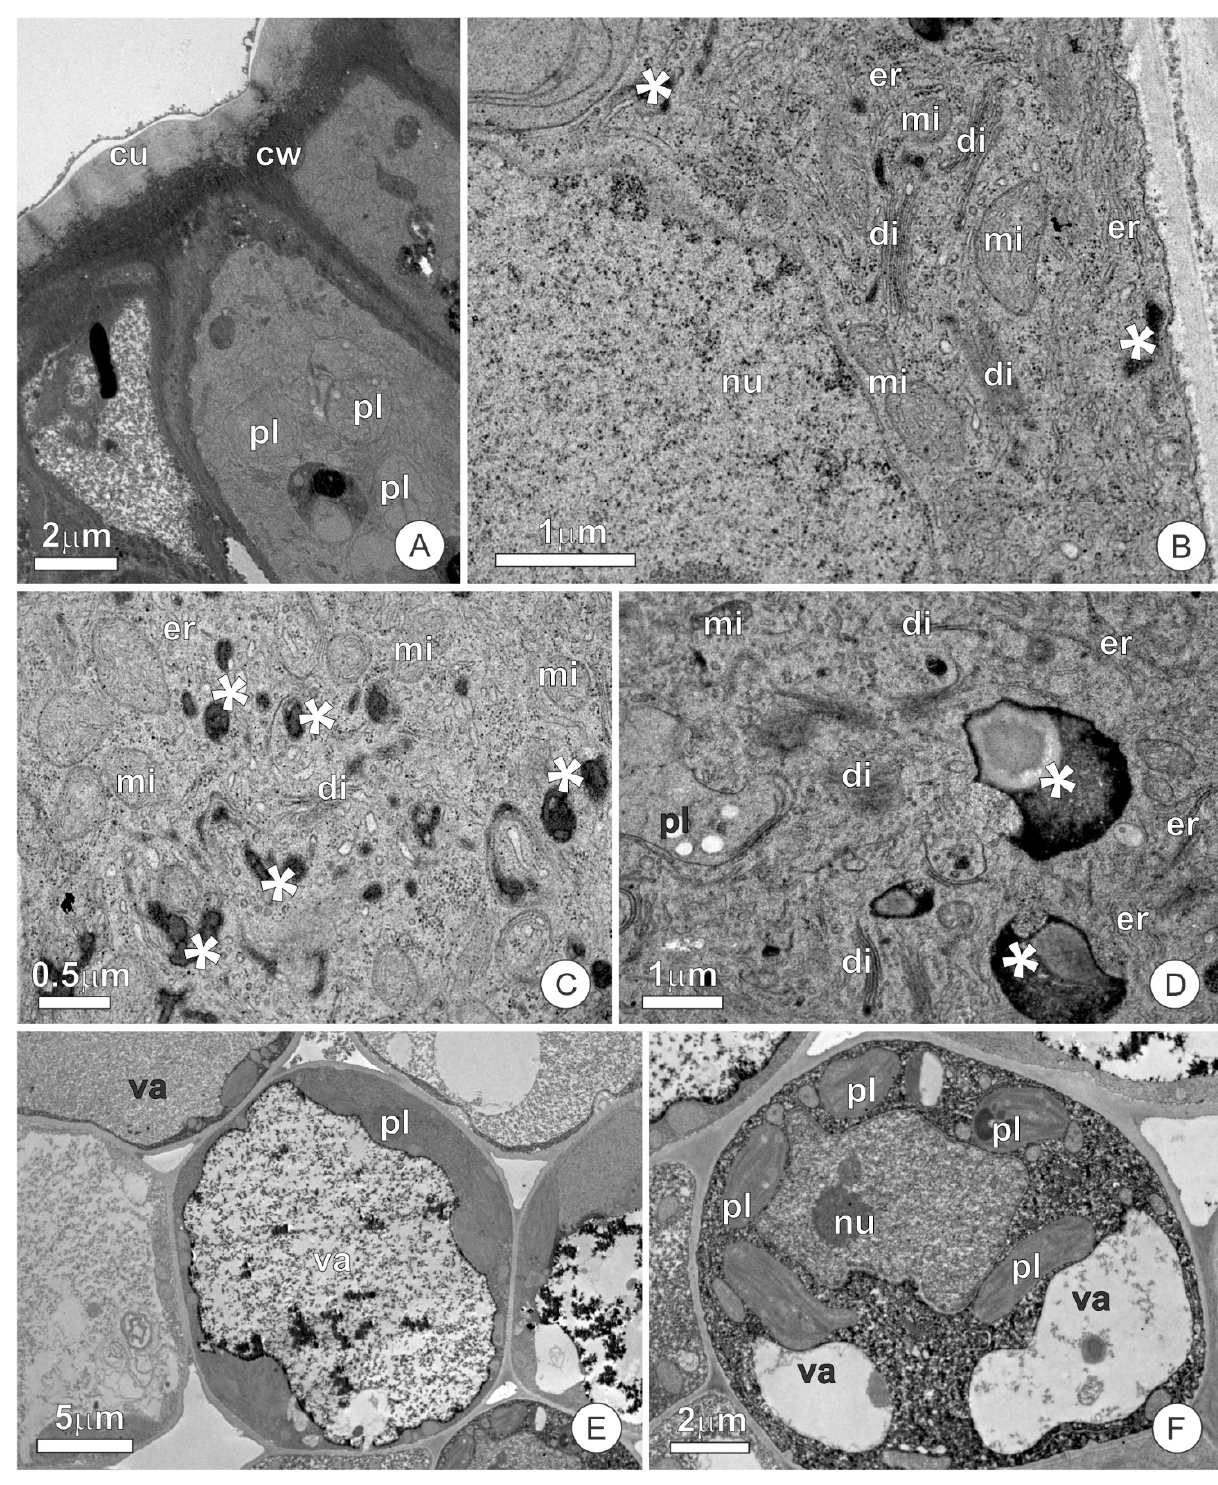
Figure 2. Ultrastructural aspects of the resin glands of O. castaneifolia : ( A ) Overall aspect of the secretory epidermis in cross-section. Note the dense protoplast of the cells. ( B – D ) Secretory cells showing organelle-rich protoplast with numerous mitochondria, dictyosomes, and segments of the smooth endoplasmic reticulum. Note the numerous deposits of osmiophilic secretion throughout the cytosol (*) ( E , F ). Cells of the subglandular parenchyma showing large vacuoles and phenolic contents. cu = cuticle, cw = cell wall, di = dictyosome, er = endoplasmic reticulum, mi = mitochondria, nu = nucleus, pl = plastid, va = vacuole.